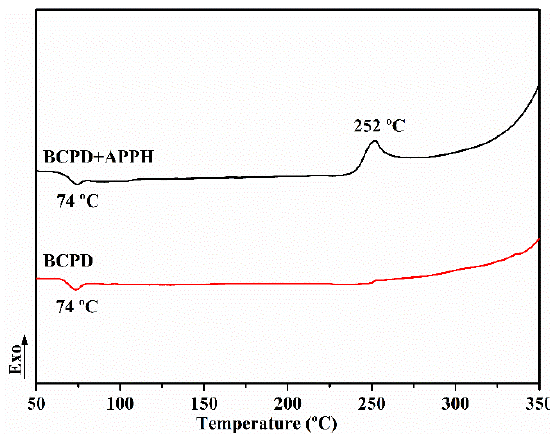
Figure 4. DSC curves of BCPD monomer and BCPD/APPH mixture.